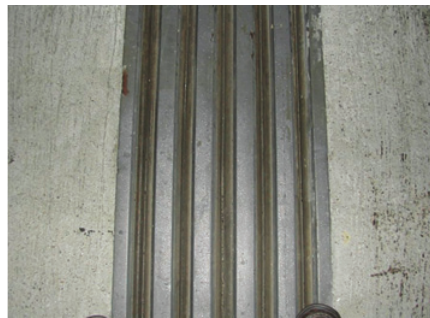
Fig. 6. The bridge movement joint on Bridge B